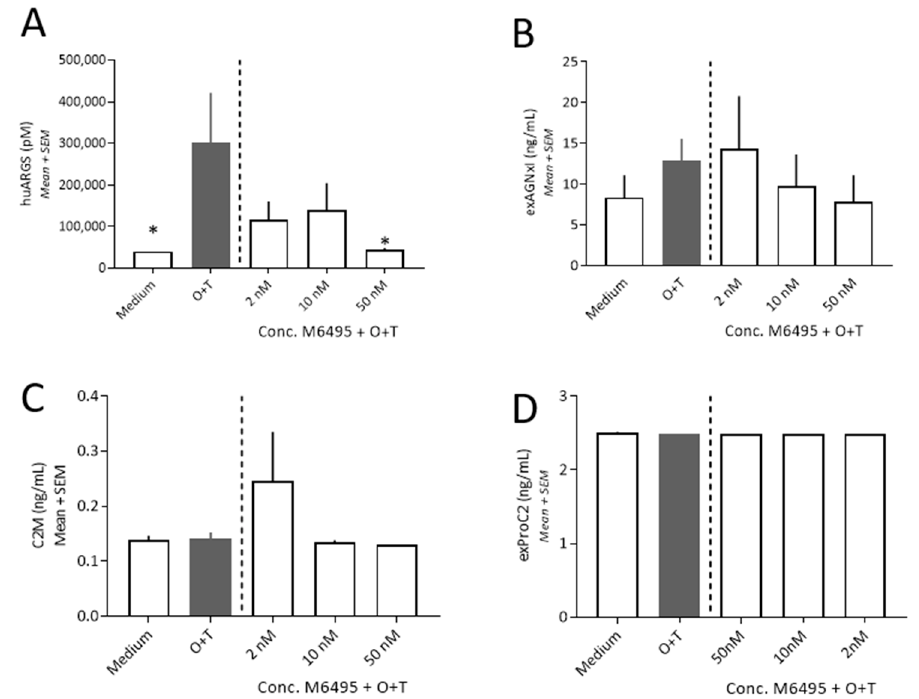
Figure 4. Cartilage turnover in healthy human cartilage explants. ( A ): ADAMTS-5 derived aggrecan degradation (huARGS) at day 5 of culture. ( B ): MMP-derived derived aggrecan degradation (exAGNx1) at day 5 of culture. ( C ): MMP-derived type II collagen (C2M) at day 21 of culture. ( D ): Formation of type II collagen (exPRO-C2) at day 21 of culture. Statistical significance was tested by one-way ANOVA with Dunnett’s multiple comparisons test comparing to O + T.; * p < 0.05. O + T did not induce a C2M release compared to medium at day 21 and M6495 did not alter the C2M release, albeit one explant of the O + T + M6495 (2 nM) had increased C2M (Figure 4B). O + T